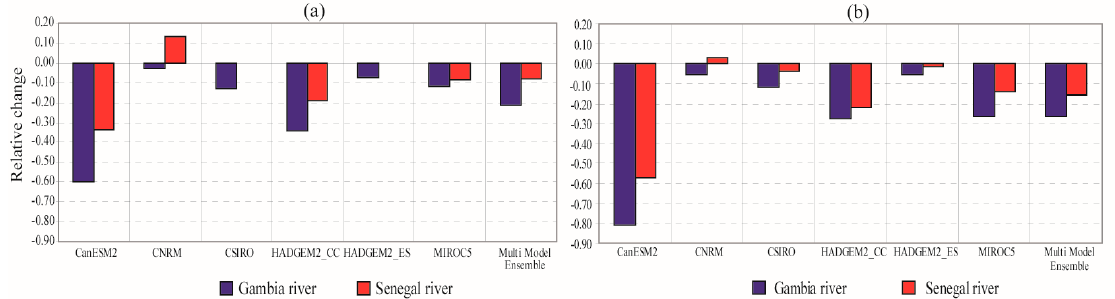
Figure 5. Relative change of mean annual streamflow for the two river basins under RCP4.5 ( a ) and RCP8.5 ( b ).